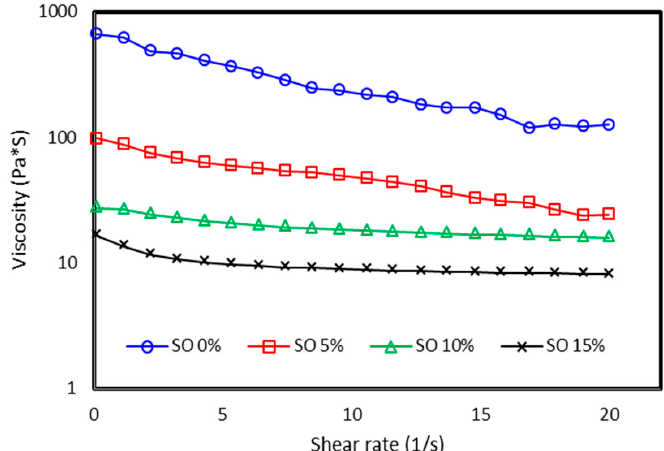
Figure 5. Viscosity of the uncured MREs with different contents of SO under different shear